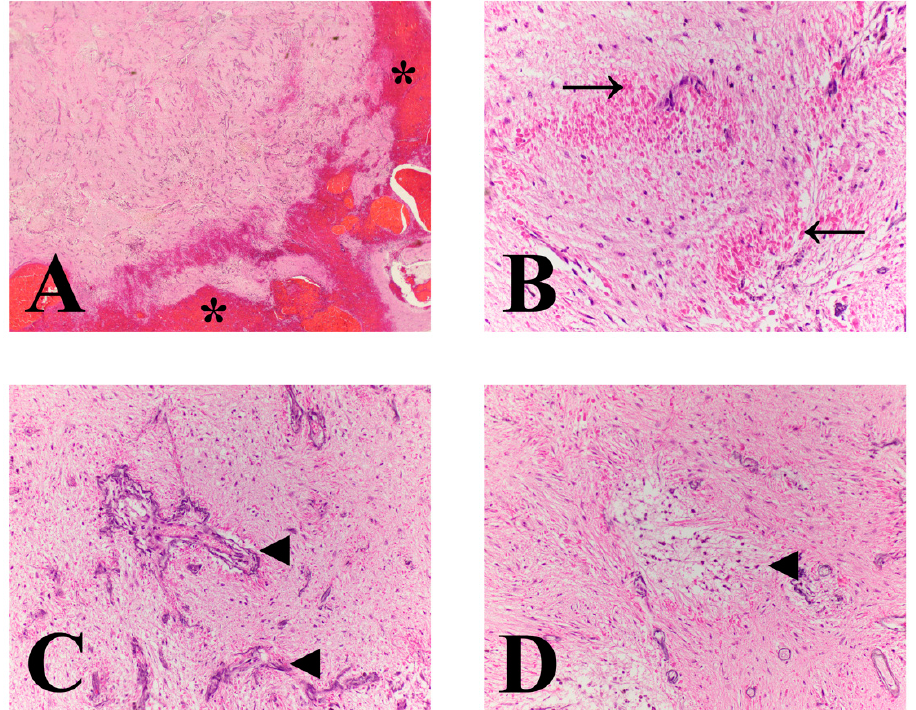
Figure 4. Microscopic features of a pilocytic astrocytoma in a dog. ( A ) Low power image at the mass interphase with mantling hemorrhage (asterisks). Mass is comprised of delicate, long fibrillated processes with numerous interspersed proliferating blood vessels. ( B ) Tumor displays long fibrillated appearance with numerous Rosenthal fibers (arrows). ( C ) Throughout the mass are numerous proliferating mineralized, tortuous and atypically branched blood vessels (arrowheads). ( D ) Neoplastic stroma is multifocally loose, separated, and vacuolated (arrowhead). The change is most prominent around blood. ( A ) magnification 20×; ( B ) and ( C ) magnification 400×; and ( D ) magnification 200×.